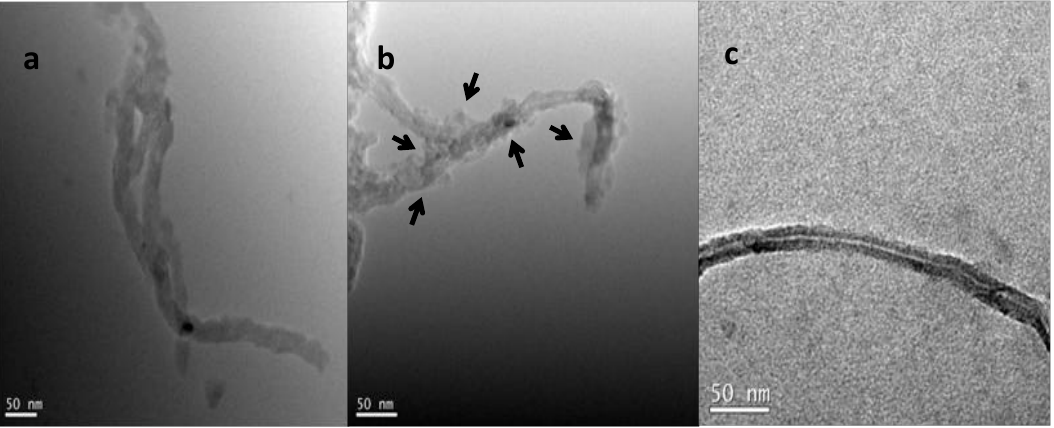
Figure 1. Transmission electron microscope (TEM) images of ( a ) oxidized multi-walled carbon nanotubes (oMWCNTs); ( b ) C (c ) C (C(COOH) ) -adsorbed oMWCNTs. 60 2 n a b